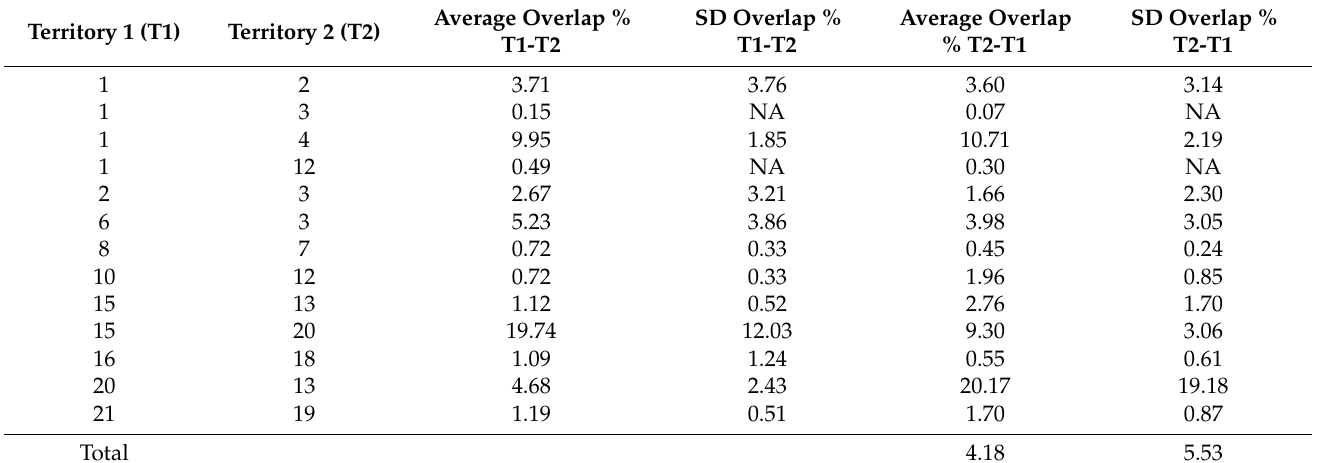
Table 3. Average and standard deviations (SD) of overlap percentages between simultaneous neigh- boring